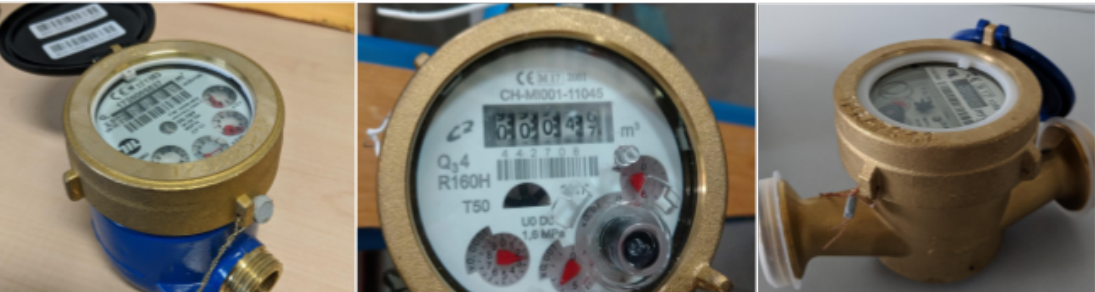
Figure 12. Three types of mechanical dumb water meters.